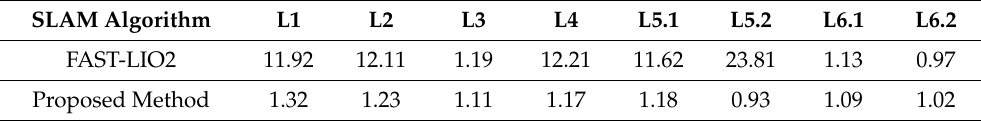
Table 1. ATE (in meters) for one- and two-loop paths in the flat section in the tunnel environment. L1–L4 represent the ATE for the one-loop paths, while L5.1–L6.2 represent that for the first and second loops of the two-loop